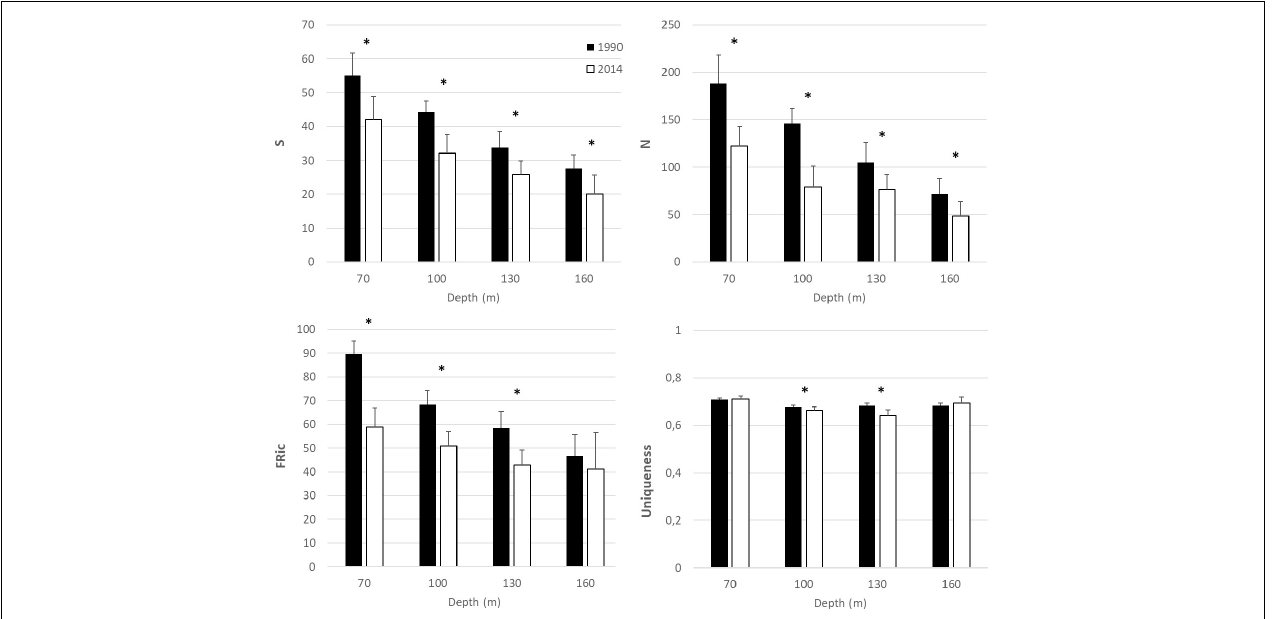
FIGURE 2 | Temporal change in alpha diversity indices (S: richness, N: total abundance, FRic: Functional richness and Uniqueness) between 1990 and 2014. Black bars indicate samples collected in 1990 and white bars in 2014. Error bars indicate standard deviation. Asterisks indicate statistically significant differences at p < 0.05. TABLE 3 | Two-way ANOVA results for the temporal comparisons of the diversity metrics (S: richness, N: total abundance, FRic: Functional richness and Uniqueness). S N FRic Uniqueness df F Sig. Sig. Sig. Sig.